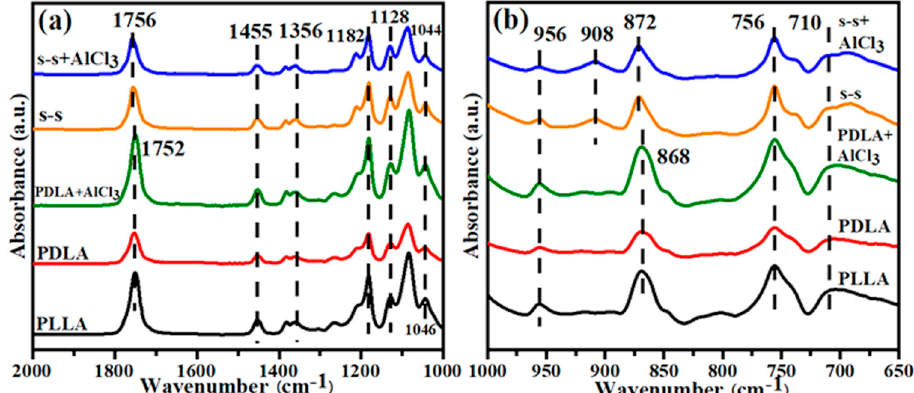
Figure 3. The FTIR spectra of PLLA, PDLA, PDLA+AlCl 3 , s-s, s-s+AlCl 3 fibers in the range of ( a ) 1000–2000 cm − 1 and ( b ) 650–1000 cm − 1 . Table 1. The chemical bond vibrations were detected from the FTIR spectra for PLA nanofibers. Assignment